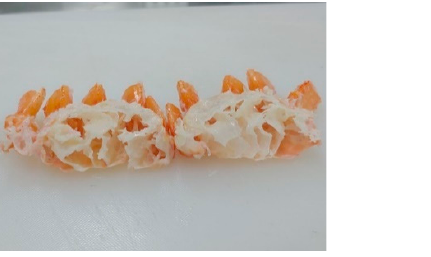
Figure 1. Images of the residues obtained from 1st body meat separation ( left ) and a crushed sample ( right ).